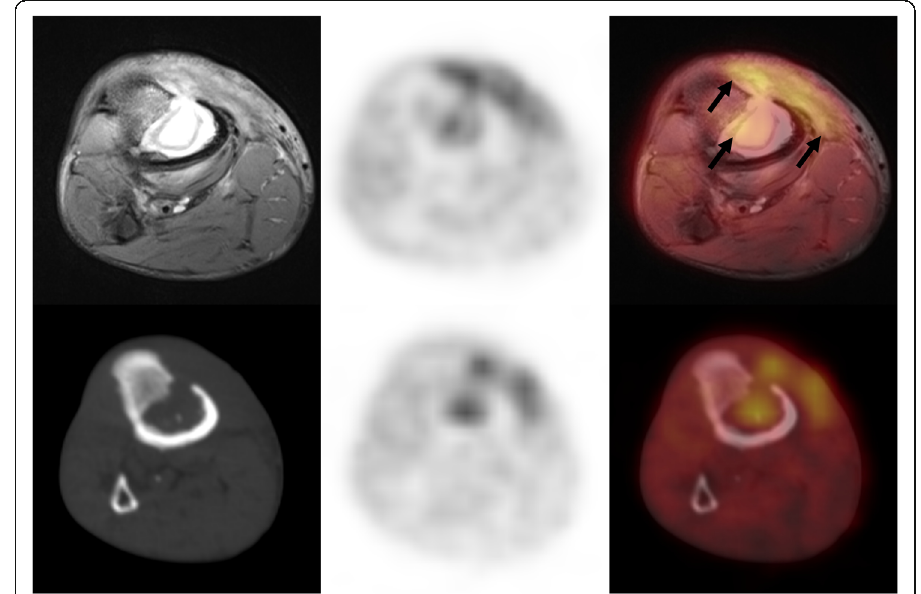
Fig. 1 Reconstructed axial images of the affected region (left tibia) from patient 1. Top row, left to right: T2- weighted MRI, PET component of PET/MRI, and hybrid PET/MRI overlay. Bottom, from left to right: CT, PET component of PET/CT, and hybrid PET/CT overlay. Black arrows denote on hybrid PET/MRI, and the area of high FDG uptake can clearly be demarcated by soft tissue features that are depicted by